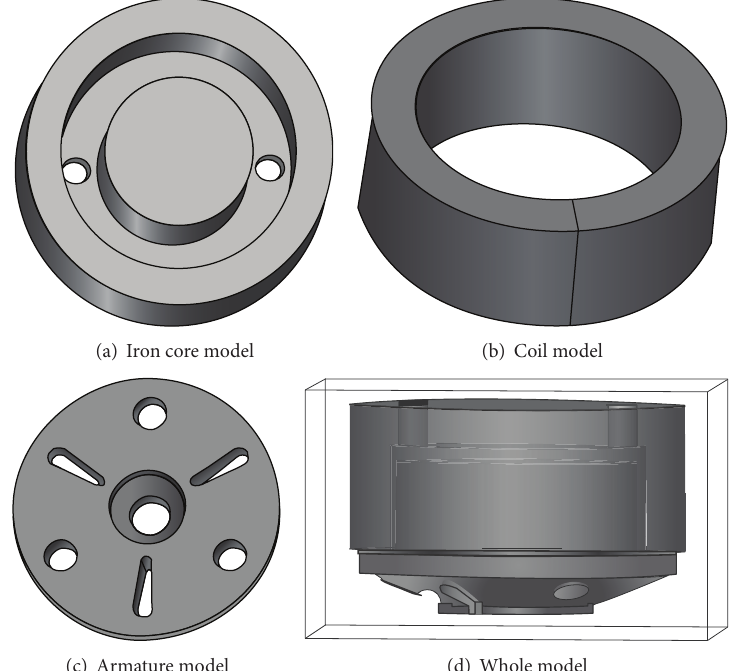
Figure 3: Ansoft simulation model of HSV.